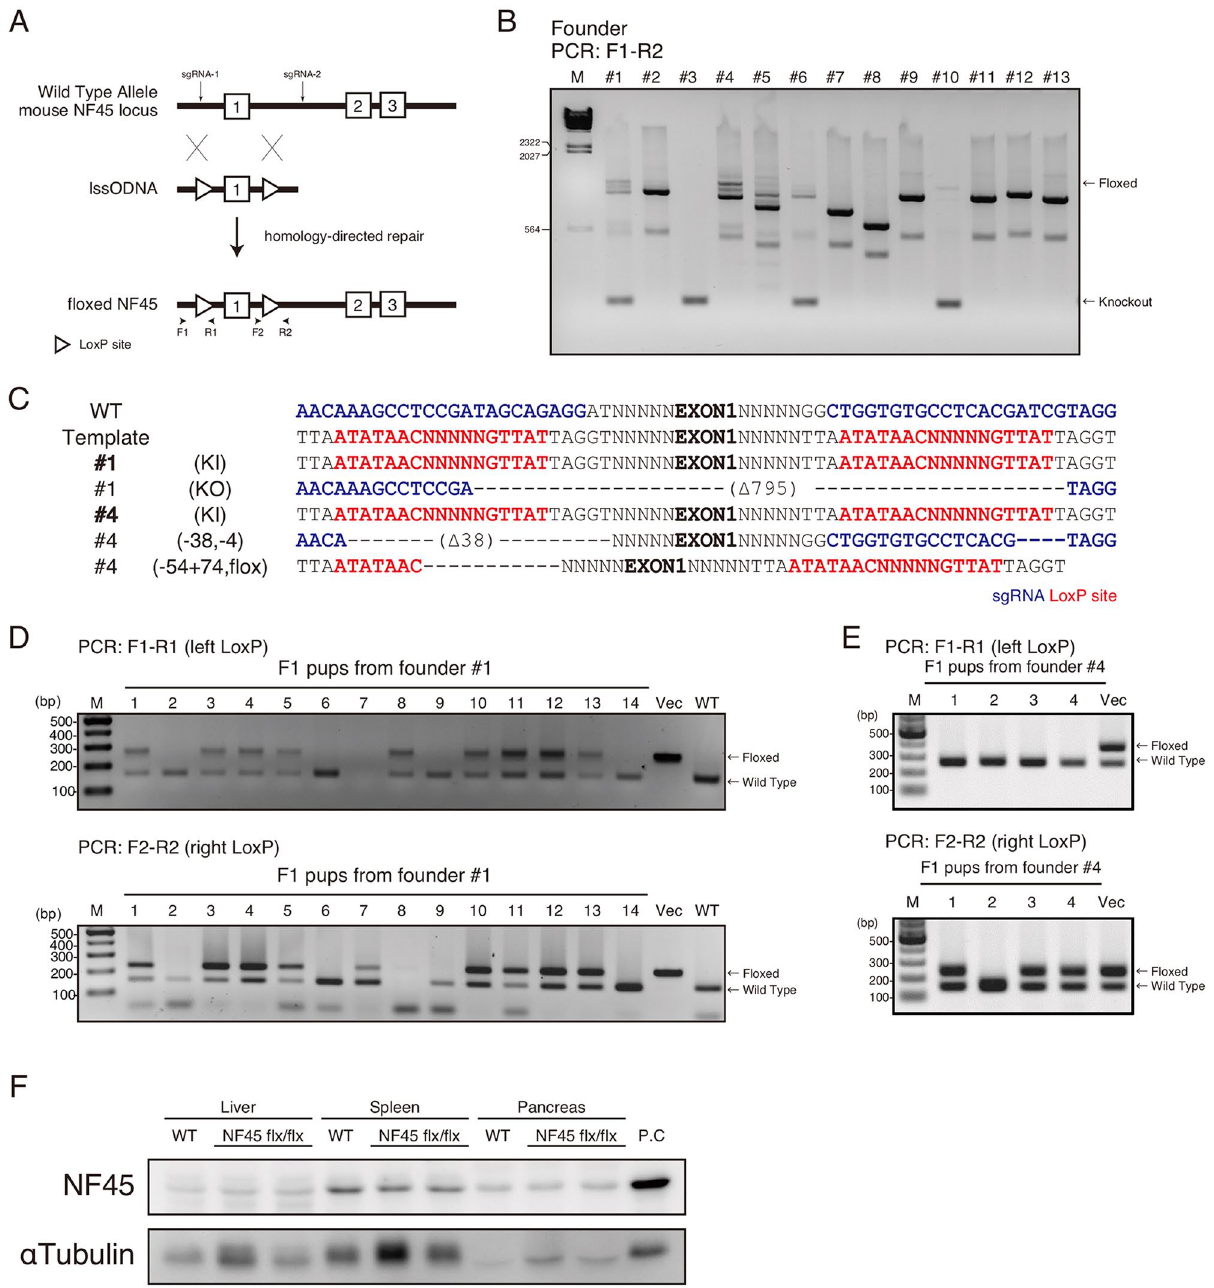
Figure 2. Generation of NF45 flox/flox mice. ( A ) Targeting strategy for the generation of NF45 floxed mice using CRISPR/Cas9 system with two single guide RNAs (sgRNAs) targeted to sequences flanking NF45 exon 1 (sgRNA-1 and 2) and a long single-stranded oligonucleotide DNA (lssODNA) containing two loxP sites flanked by short arms with homology to the desired insertion sites. ( B ) Genotyping of founder mice (#1–#13) injected with sgRNAs-1 and -2, lssODNA and Cas9 mRNA. PCR products corresponding to floxed NF45 locus or knockout of the NF45 locus were indicated by an arrow. M, λHindIII marker ( C ) DNA sequencing of the CRISPR/Cas9-targeted NF45 locus of founder mice #1 and #4. SgRNAs and loxP sites were showed as blue and red, respectively. ( D and E ) Genotyping of F1 pups derived from founder #1 and #4 by PCR using primer pairs targeted loxP sites shown in A. M, 100 bp DNA ladder. ( F ) Western blot analysis of the levels of NF45 in liver, spleen and pancreas from wild-type and NF45 flox/flox (flx/flx) mice. P.C, positive control. Protein extraction from murine testis was used as positive